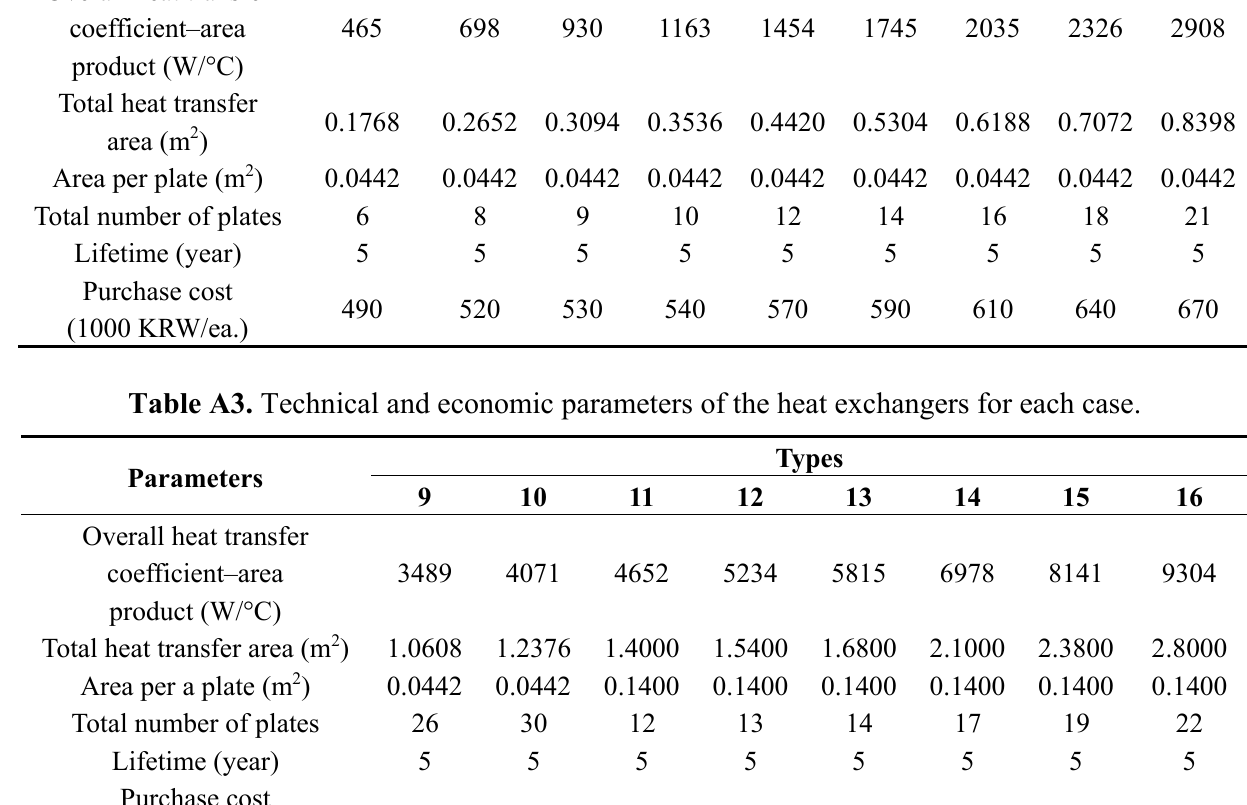
Table A2. Technical and economic parameters of the heat exchangers for each case. Parameters